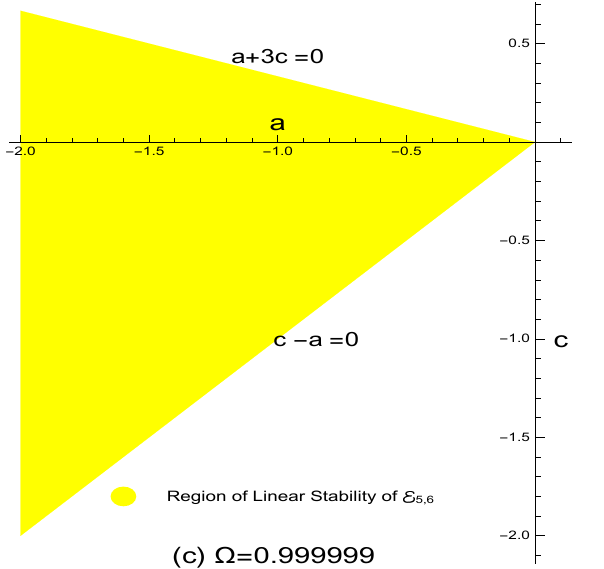
Figure 3. Regions of stability and instability for the equilibrium position E 5,6 on the plane of the parameters c and a